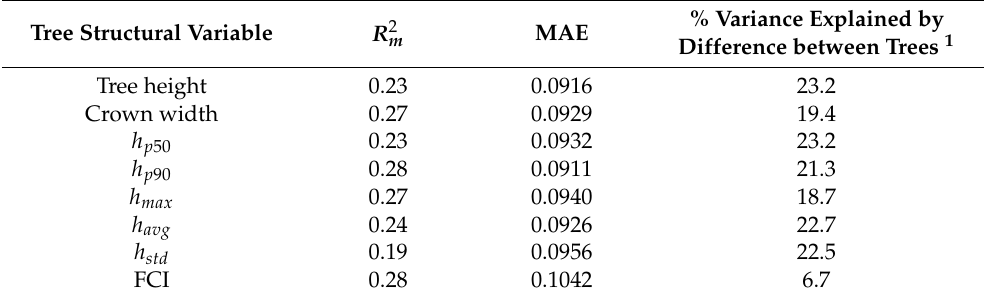
Figure 5. Pearson correlation coefficient between albedo and tree structural variables. Note: * indicates p -values < 0.1, while *** indicates p -values < 0.001. Table 4. Marginal R 2 ( R 2 m ), mean absolute error (MAE) and proportion of variance (in %) explained by differences between tree objects after accounting for the fixed effects variance for the LMMs fitted for each of the tree structural variables, one at a time.